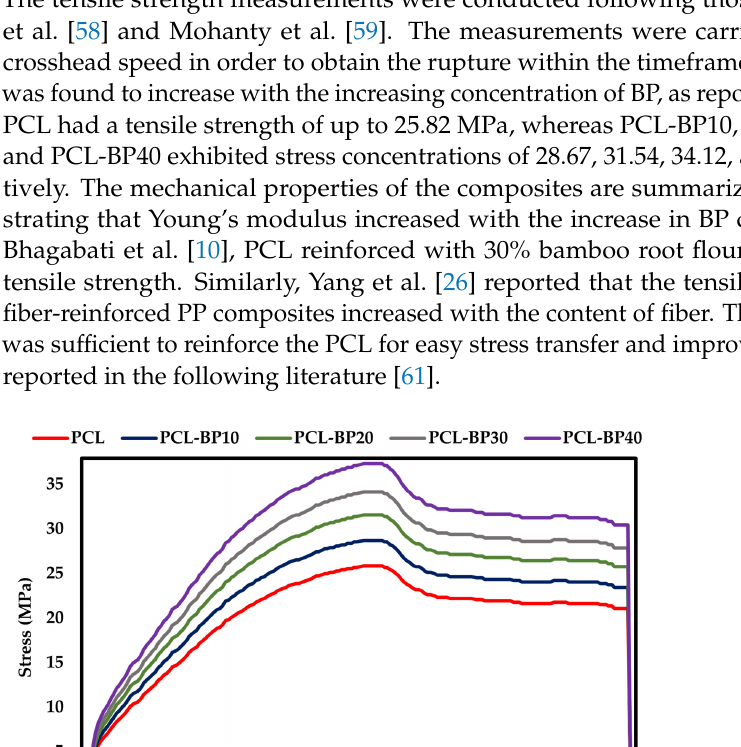
Figure 7. Soil burial degradation of PCL and PCL-BP composites ( n = 3, * p ≤ 0.05, ** p ≤ 0.01).